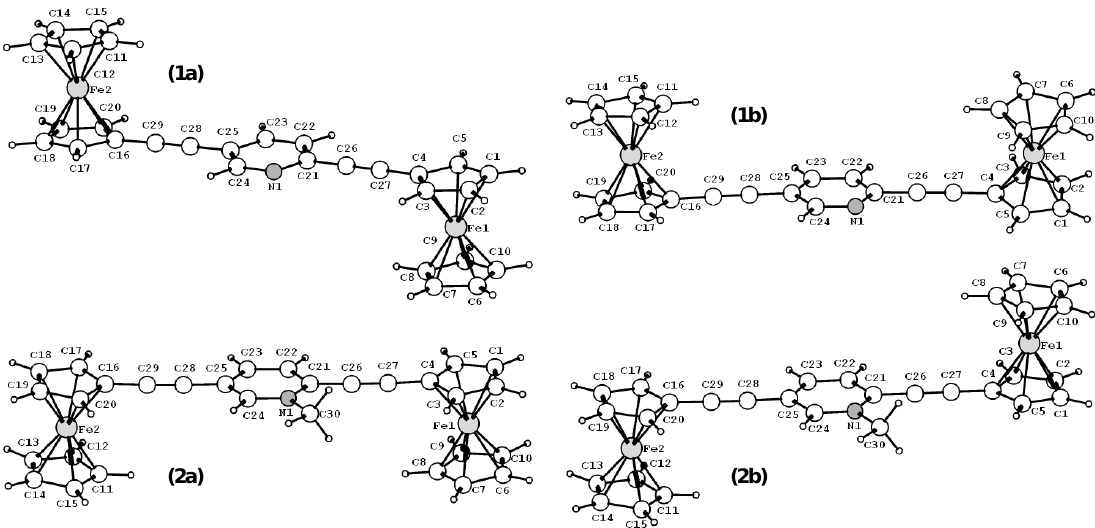
Figure 2. DFT optimized geometries of compounds 1 and